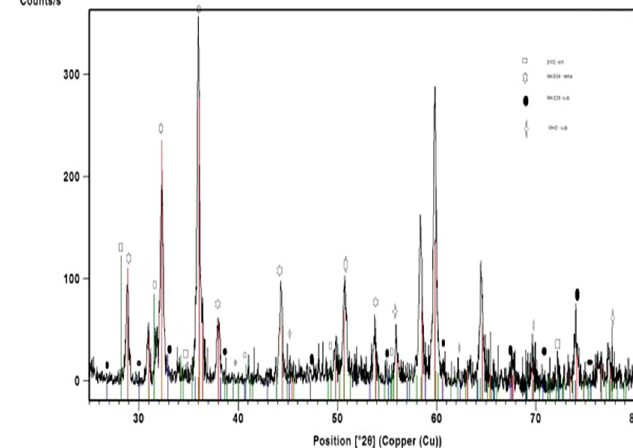
Fig. 9. XRD patterns of nano-SPVD powders of MnO doped